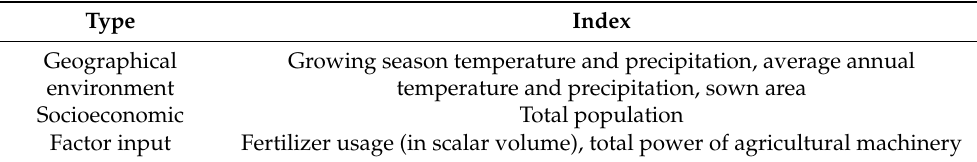
Table 1. Factors influencing food